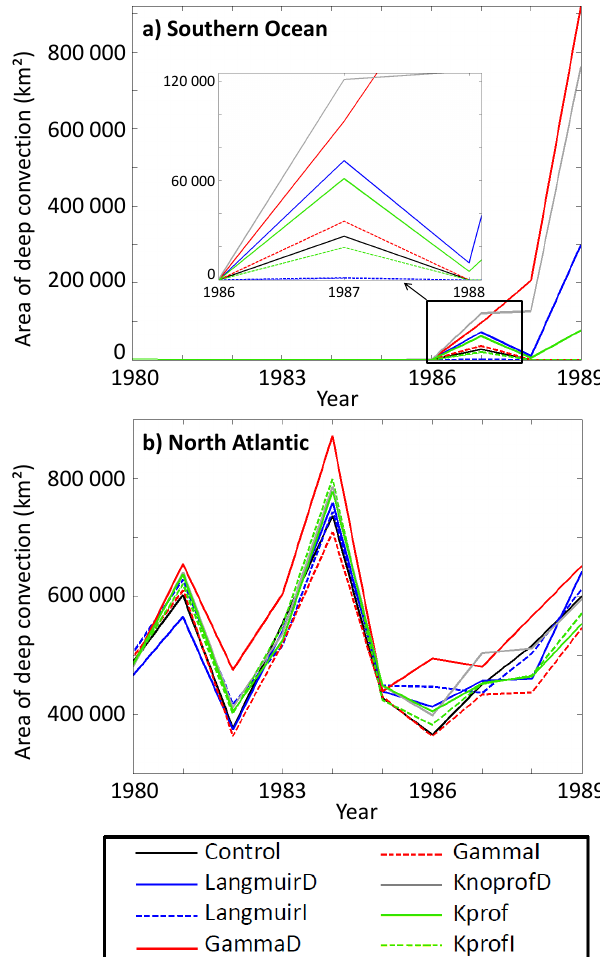
Figure 7. For each experiment, annual maximum area of deep con- vection in (a) the Southern Ocean and (b) the North